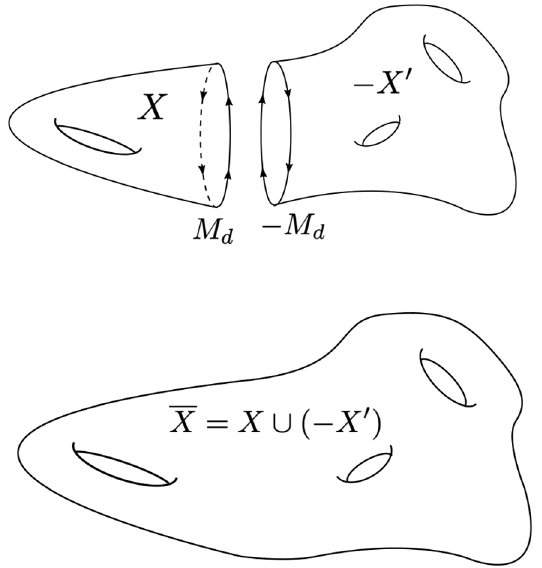
Figure 1. Gluing of two manifolds X and X 0 with a shared boundary component M d , under which the exponentiated η -invariant factorizes due to a theorem of Dai and Freed